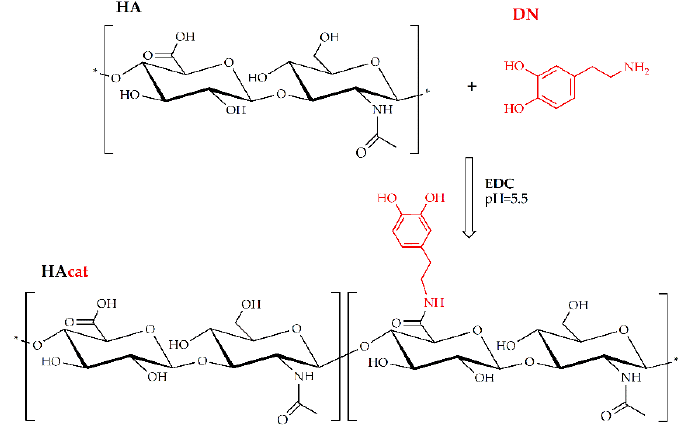
Figure A8. Scheme for synthesis of CHIcat, describing the conjugation strategy of chitosan (CHI) to hydrocaffeic acid (HCA), using EDC chemistry.